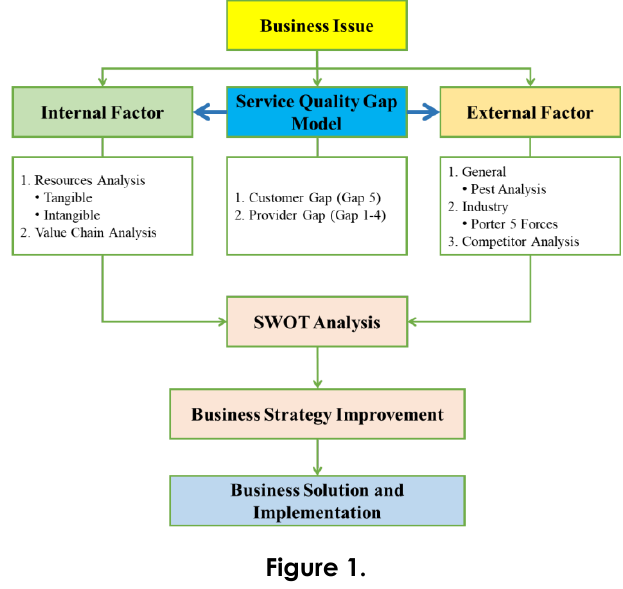
Figure 1. Conceptual